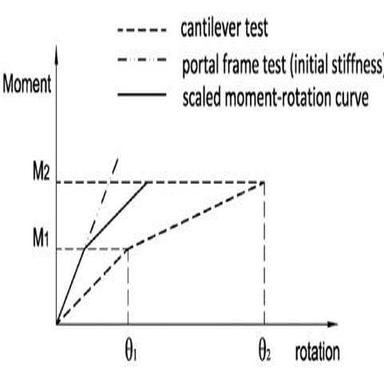
Moment-rotation curve of the semi-rigid joint.